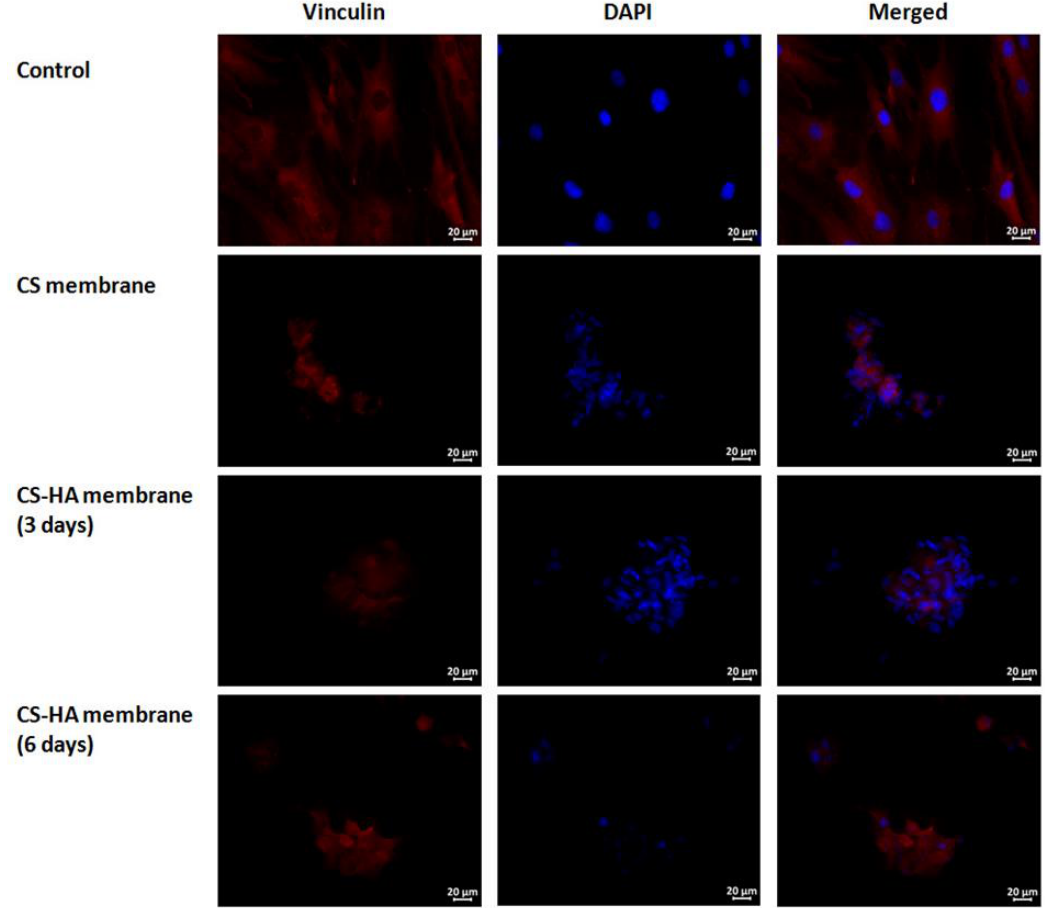
Figure 5. Representative cell morphology after three days of co-cultivation of mesenchymal stem cells (MSC) and cover glass (first row), CS sca ff old (second row), and CS–HA sca ff old (third row) and after six days of co-cultivation with CS–HA sca ff old (fourth